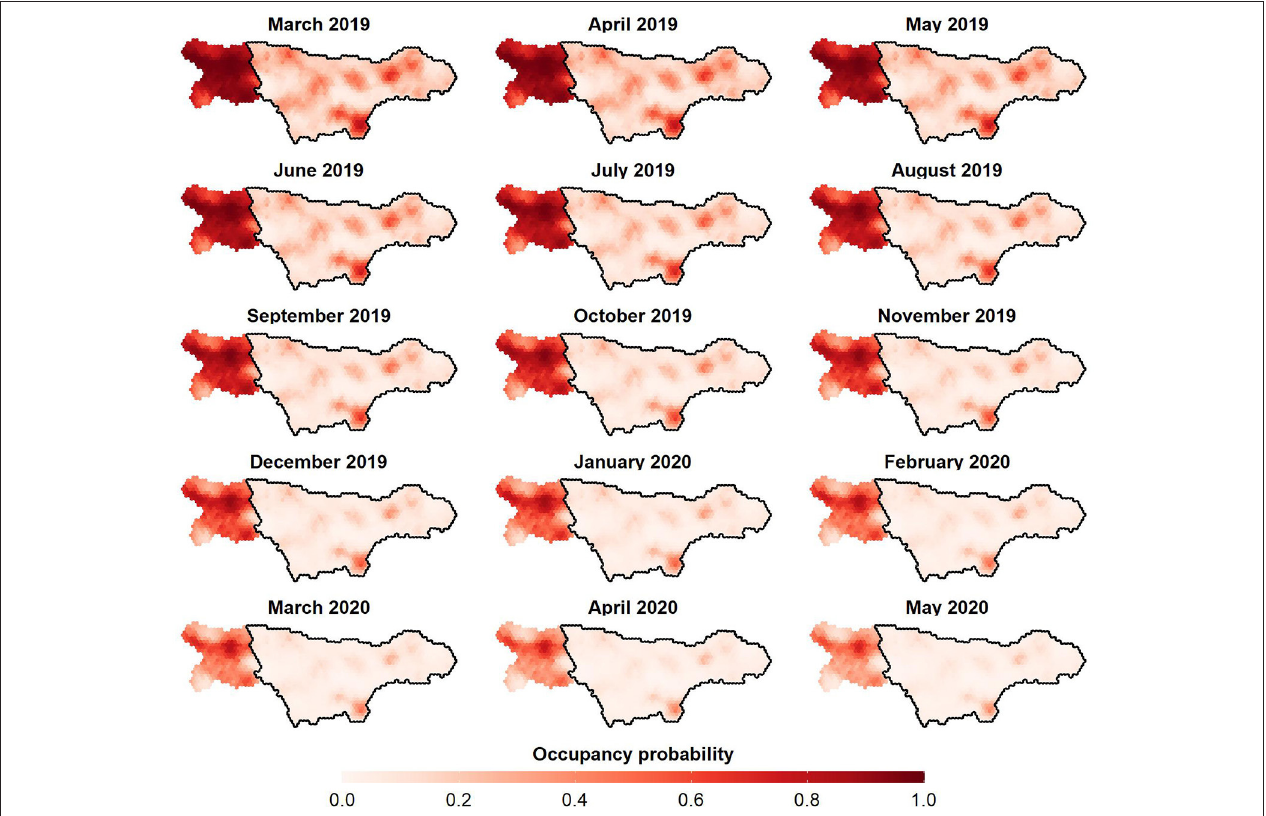
FIGURE 3 | Posterior mean occupancy of wild boar in the ASF-infected (enclosed by the black line) and non-infected (non-enclosed) zone in Wallonia (Belgium). Panels ranging from March 2019 until May 2020.